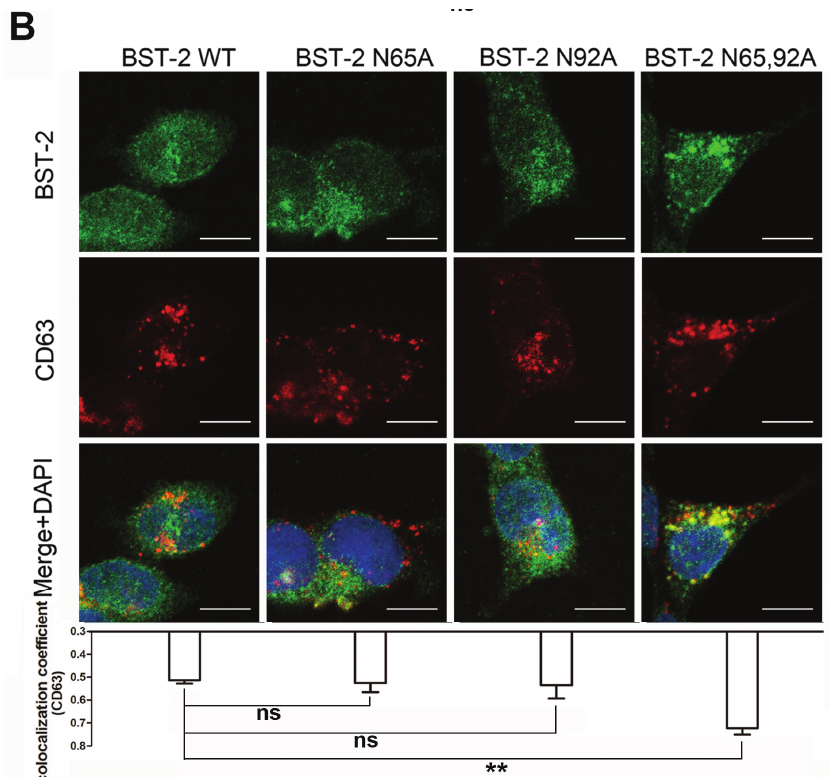
Figure 2. Impairment of N-linked glycosylation induces enhanced subcellular distribution of BST-2 in CD63-positive vesicles. ( A ) 293T cells stably expressing BST-2 or its variants were stained; blue, cell nucleus; green, BST-2 protein; red, ER-Tracker; ( B ) 293T cells stably expressing BST-2 or its variants were stained; blue, cell nucleus; green, BST-2 protein; red, CD63-PE. Images were taken under a Zeiss LZM710 confocal microscope. At least 30 individual cells were examined in each sample, and the most representative cells are shown. The co-localization coefficient (R) was calculated using Image-Pro Plus 6.0. Results were shown as mean ± SD. Statistical comparisons between the groups were performed by unpaired t -test using GraphPad Prism 5. ** p < 0.01, ns (not significant) p > 0.05. Scale bars = 10 µ